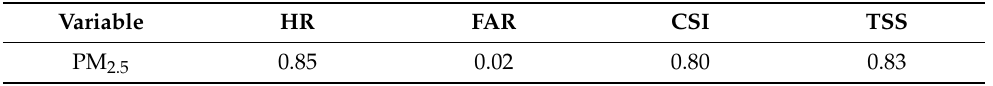
Table 9. Evaluation of predictions for high PM2.5 concentration using CB model on the test dataset.